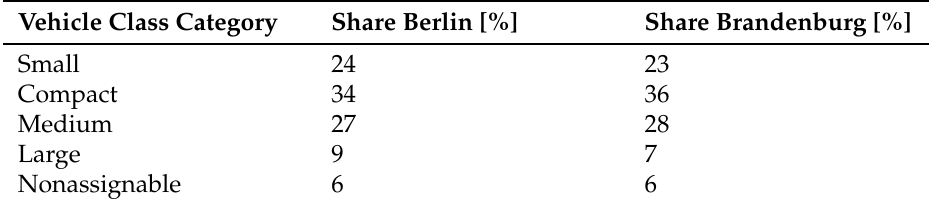
Table 2. Distribution of vehicle classes in Berlin/Brandenburg ([p. 254] in